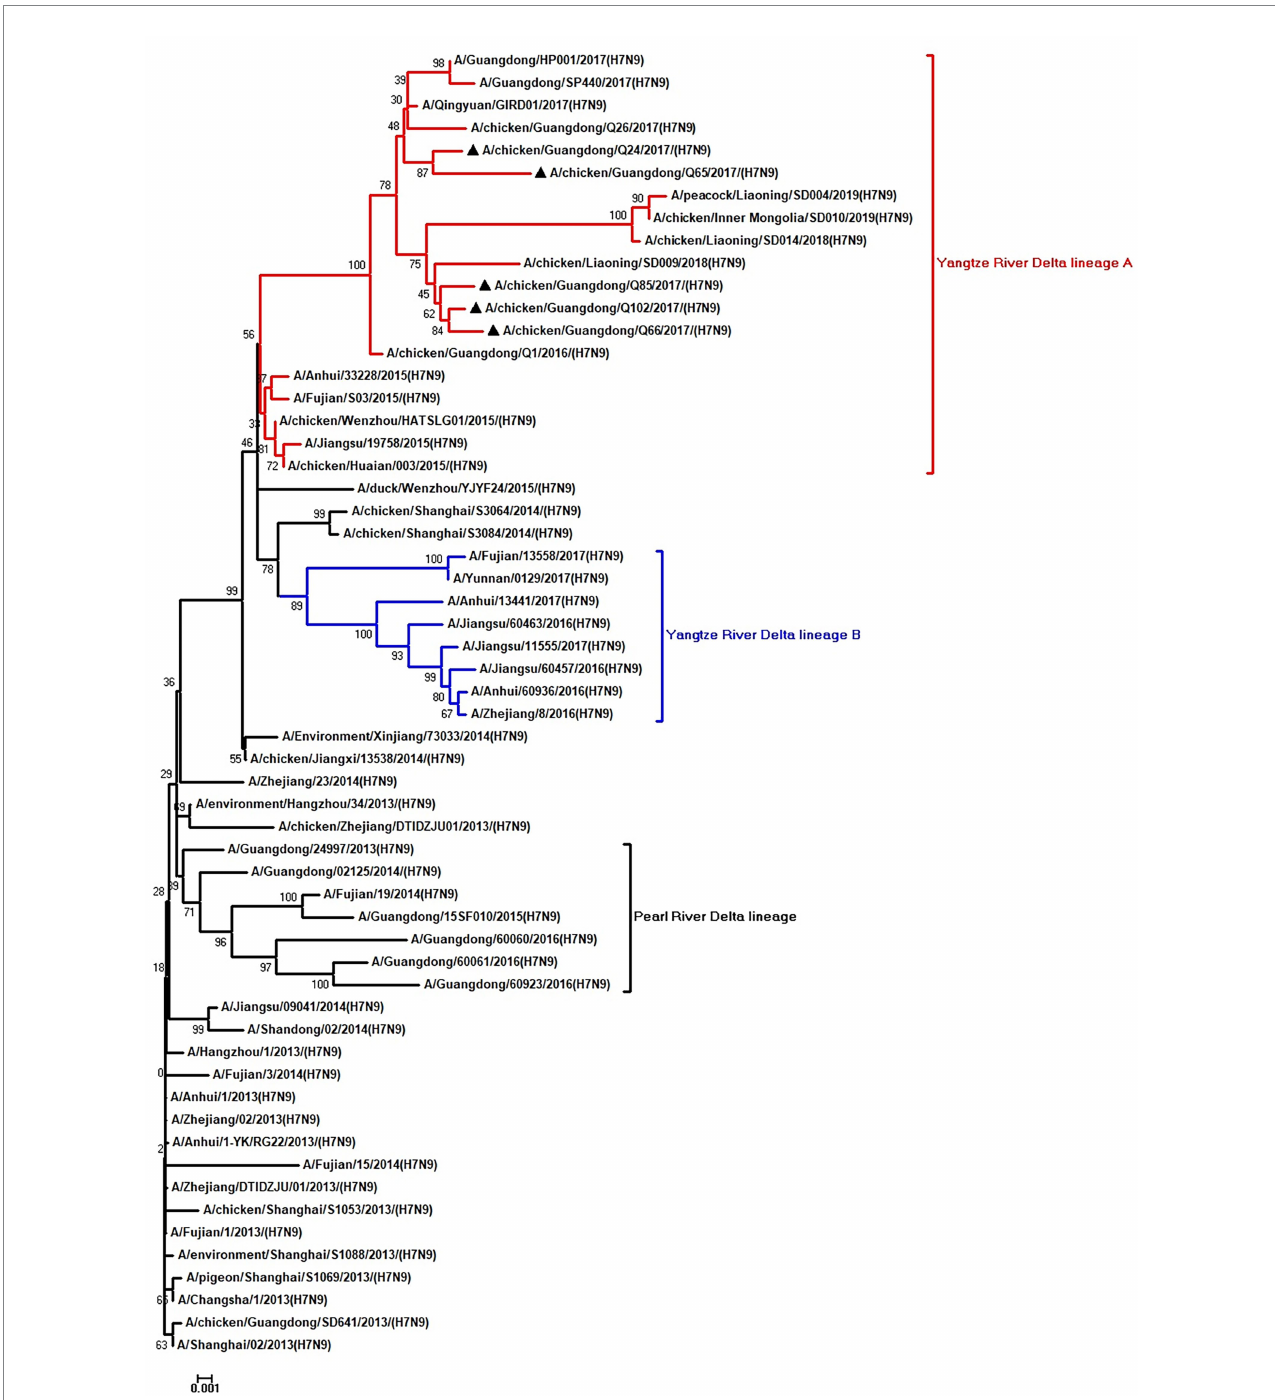
FIGURE 1 Phylogenetic analysis of HA. The tree was constructed by using the neighbor joining method with the Maximum Composite Likelihood model and MEGA version 5.2 (www.megasoftware.net/) with 1,000 bootstrap replicates based on the following sequences: HA: nucleotides (nt) 1–1,695. Except our five isolates, other virus sequences were downloaded from GenBank. Triangles indicate the viruses characterized in this study. The scale bar indicates the branch length and corresponds to 0.001 estimated amino acid substitutions per